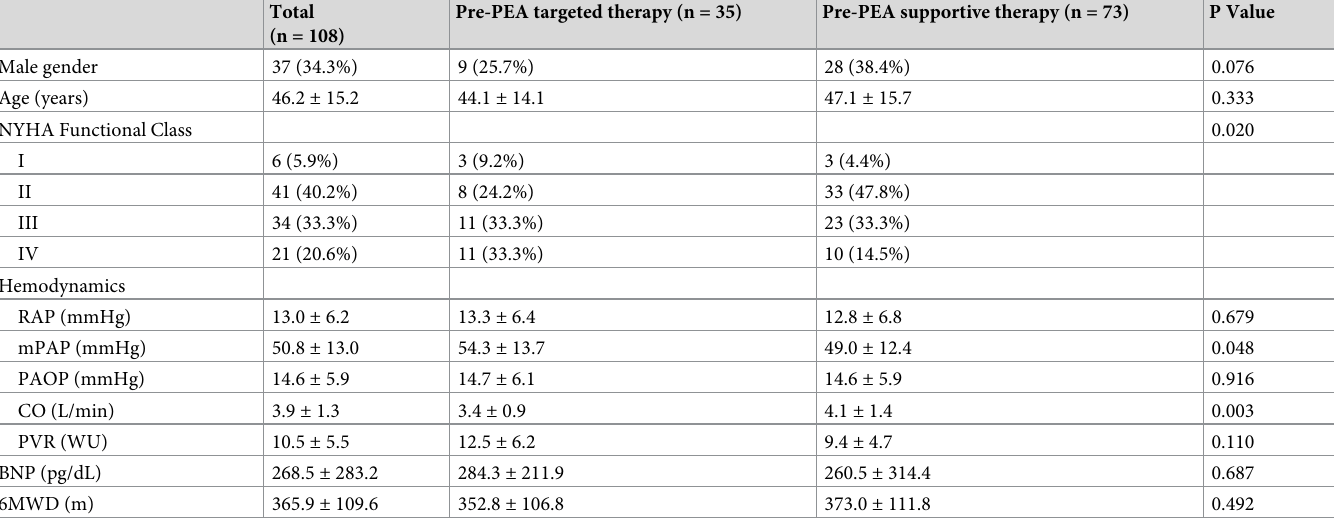
Table 1. Baseline characteristics according to the use of targeted